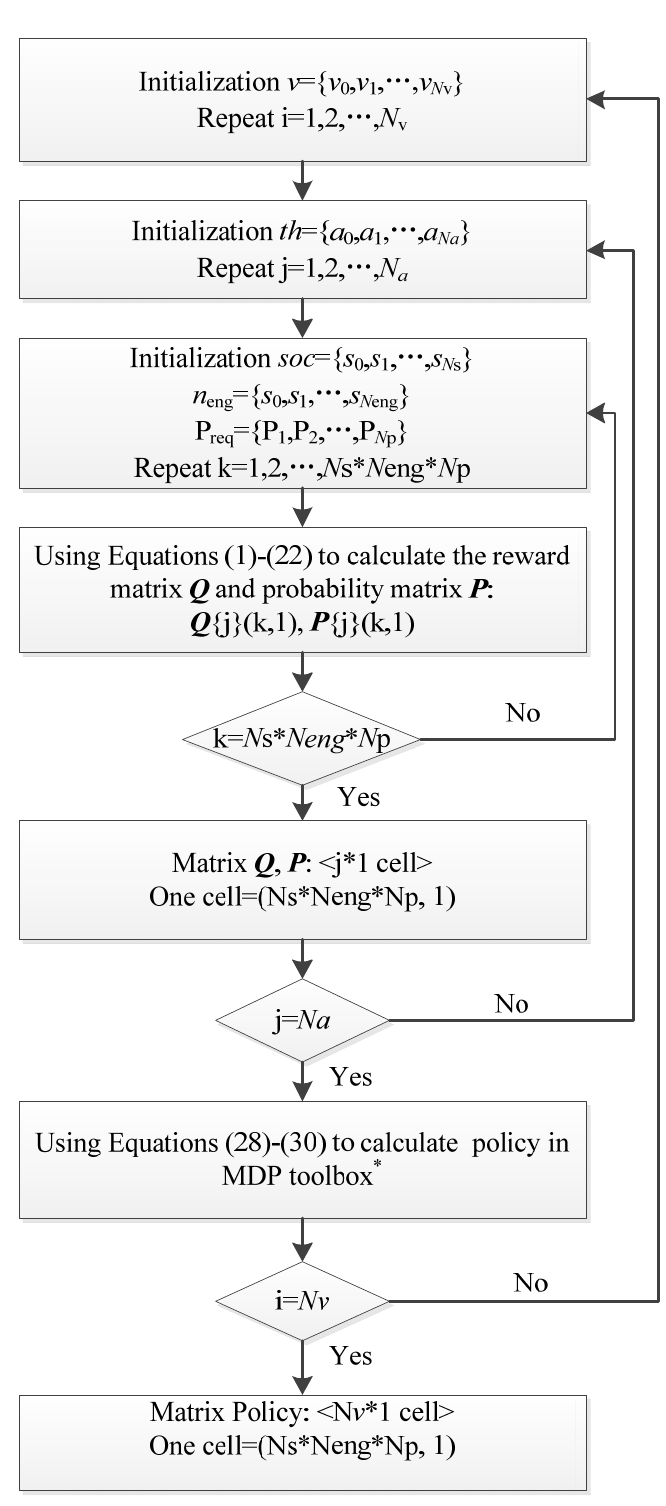
Figure 8. Computational flowchart of the Q -learning and Dyna algorithms. * The MDP toolbox is introduced in